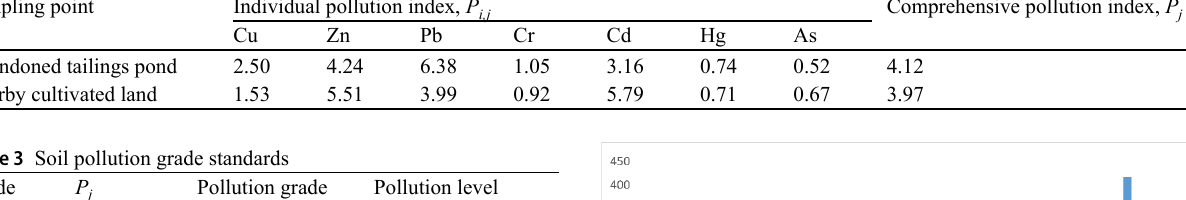
Table 2 Pollution index results Sampling point